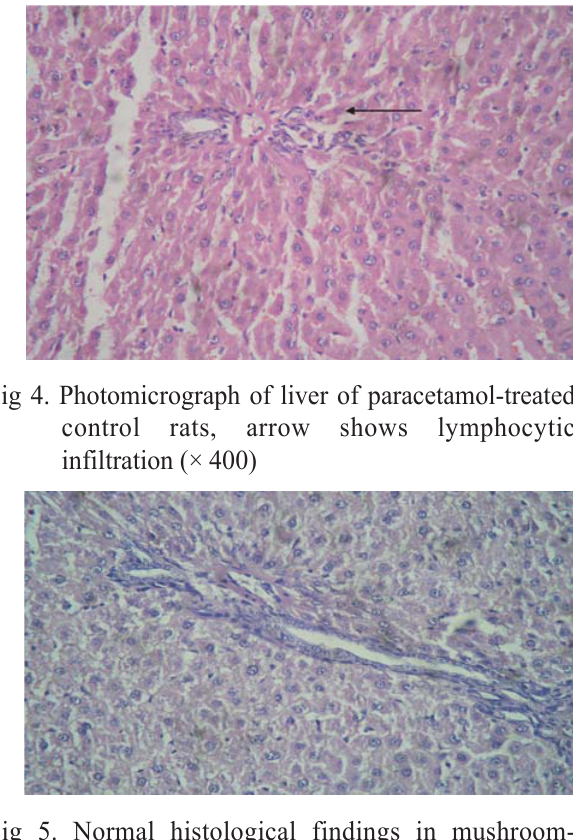
Fig 5. Normal histological findings in mushroom- pretreated and paracetamol-treated control rats (×